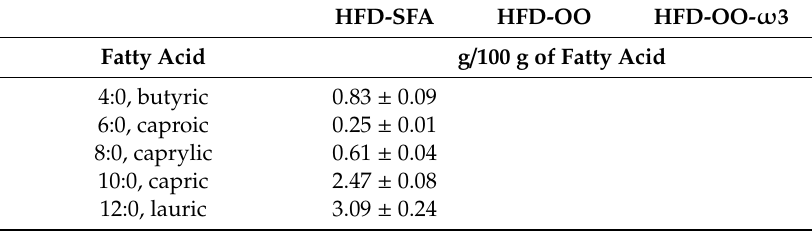
Table 2. Fatty acid composition of dietary fats for corresponding high-fat diet